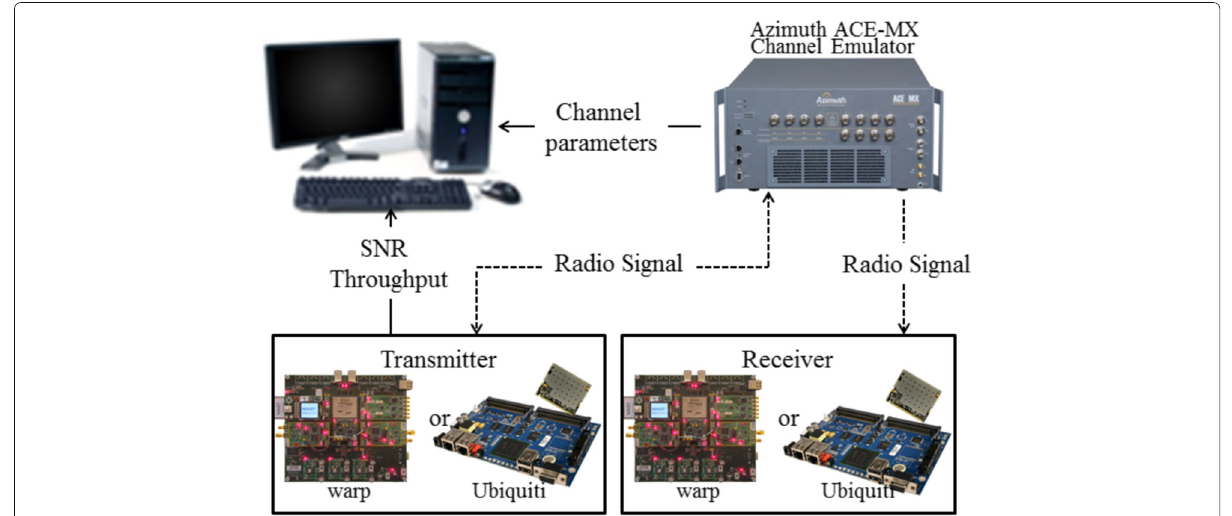
Fig. 4 Set-up of the emulator-based experiment. This figure shows the set-up of the emulated environment for experiments, including the equipments and the connections between equipments